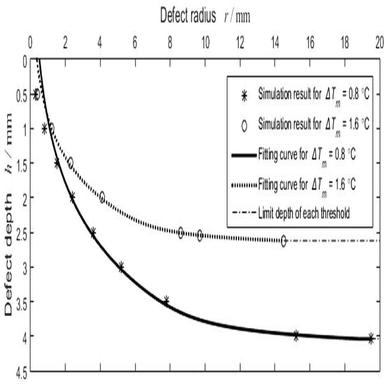
Differential temperature contour map using bi-exponential function fitting forq0 = 2.0 × 106 W/m2.